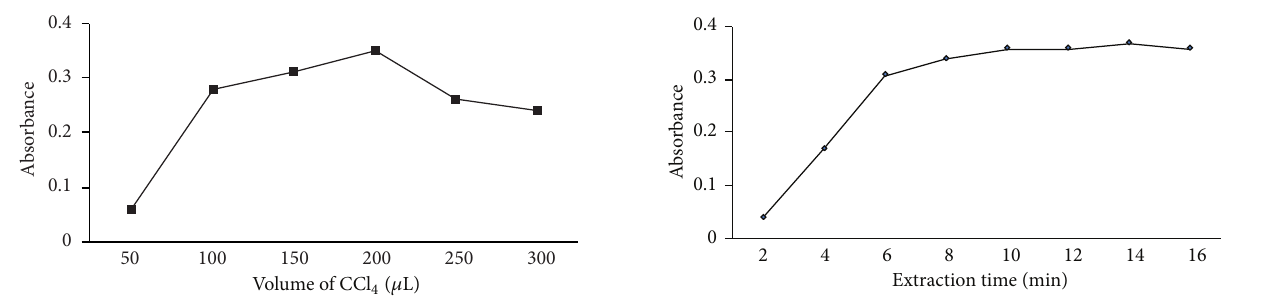
Figure 3: Effect of the extraction solvent volume on the analytical responses,conditions:samplevolume5.0 mLcontaining1.0ngmL −1 Zn(II), dispersive solvent 1mL ethanol, extraction solvent CCl 4 containing 2.5 × 10 −6 mol L −1 PPT, extraction time 10min.